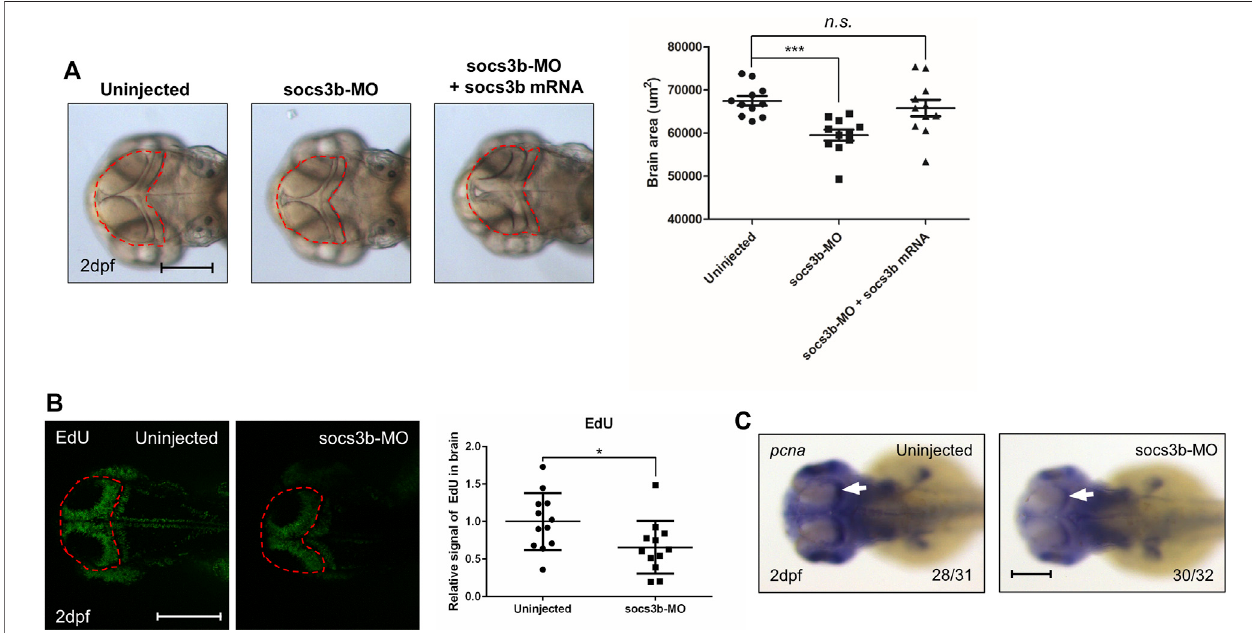
FIGURE 6 | The zebra fi sh analogue socs3b governs brain development by regulating proliferation. (A) Representative images of A172 cells were obtained using a microscope fi tted with a digital camera (scale bars, 300 µm). Different concentrations of DHE were added to the culture media of the glioblastoma A172 cells, and cell viability was measured using the MTT assay. (B) Dorsal view of live images with uninjected control embryos, socs3b-MO-injected embryos, and socs3b-MO- and socs3b-mRNA-co-injected embryos (left panel, red dotted lines indicate brain area), and quanti fi ed data of the brain area using ImageJ (right panel) . (C) Dorsal view of confocal images after EdU staining with uninjected embryos and socs3b-MO-injected embryos (left panel, red dotted lines indicate brain area), and quanti fi ed intensityofEdU signals (rightpanel) . (D) DorsalviewofWISHimagesusing thecellproliferation markerpcnainuninjectedembryos andsocs3b-MO-injected embryos. Scale bars indicate 200 µm in each image (*** p < 0.0001, * p <